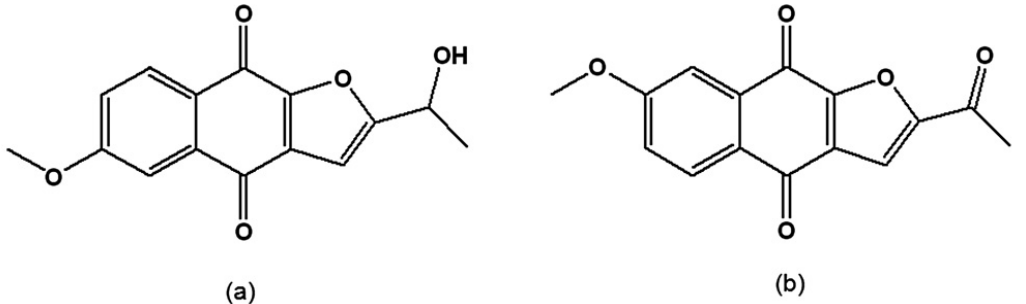
Figure 7. (a) 2-(1-Hydroxyethyl)-6-methoxy-naphtho[2,3- b ]furan-4,9-quinone; (b) 2- Acetyl-7-methoxy-naphtho[2,3- b